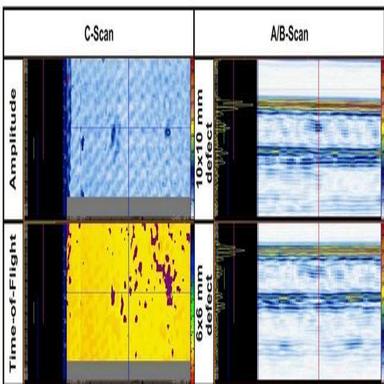
Ultrasonics investigation of panel 5.